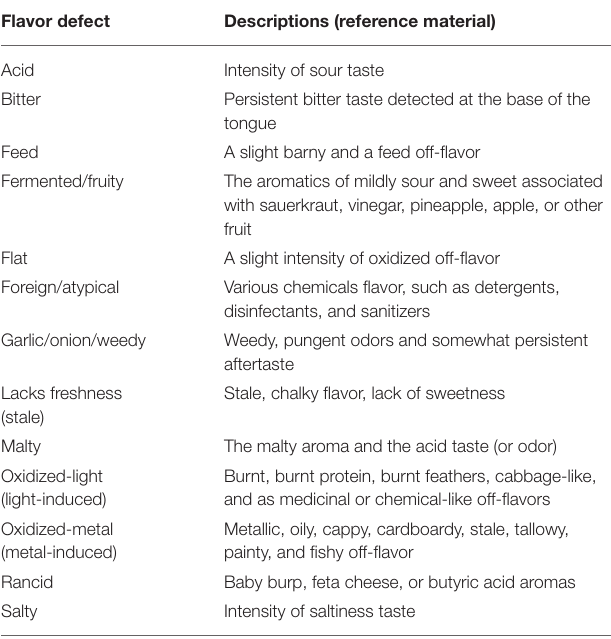
TABLE 1 | The scoring and grading of sensory evaluation of milk flavor. Flavor